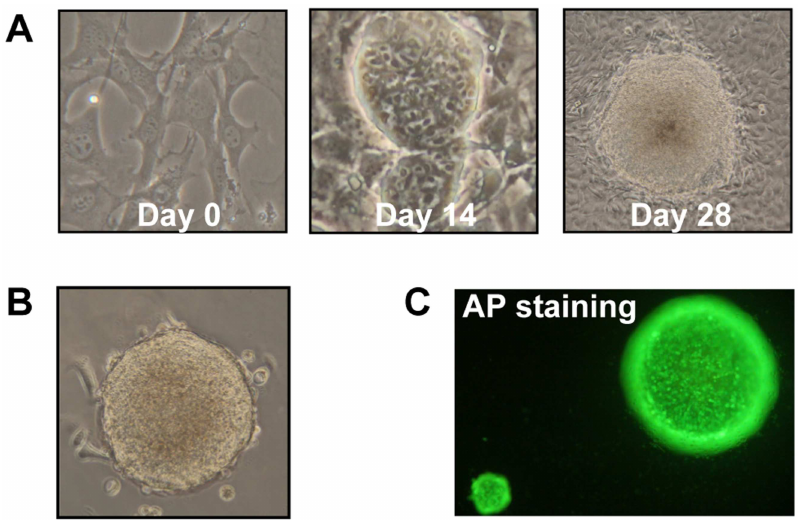
Fig 1. Reprogramming of EiPSCs. (A) Phase contrast images of the EiPSCs reprogrammed from MEFs at days 0, 14 and 28. (B) Microscopy images of embryoid bodiesformed from EiPSCs. (C) EiPSC spheres stained for alkaline phosphatase